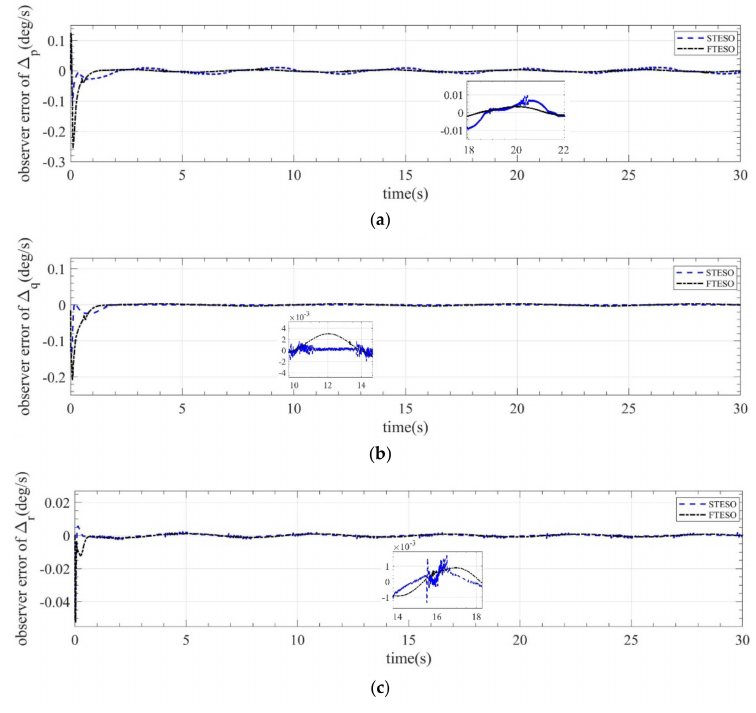
∼ ∆ p , ( b ) observer error tracking curve of